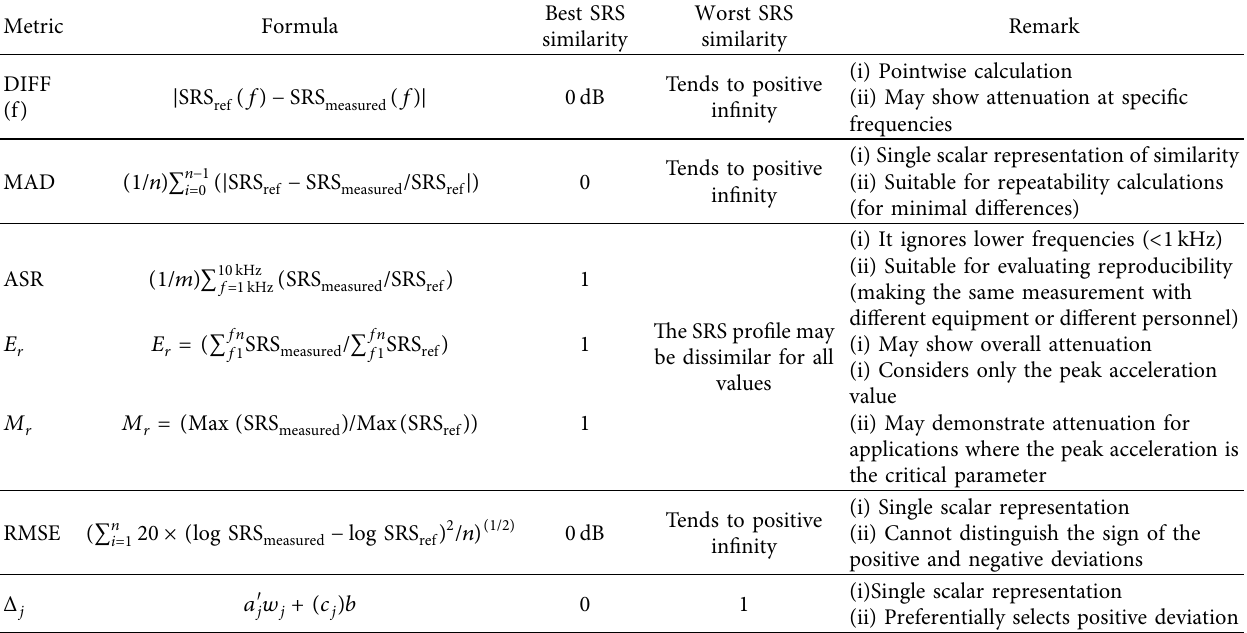
Table 1: Summary of database SRS retrieval metrics.